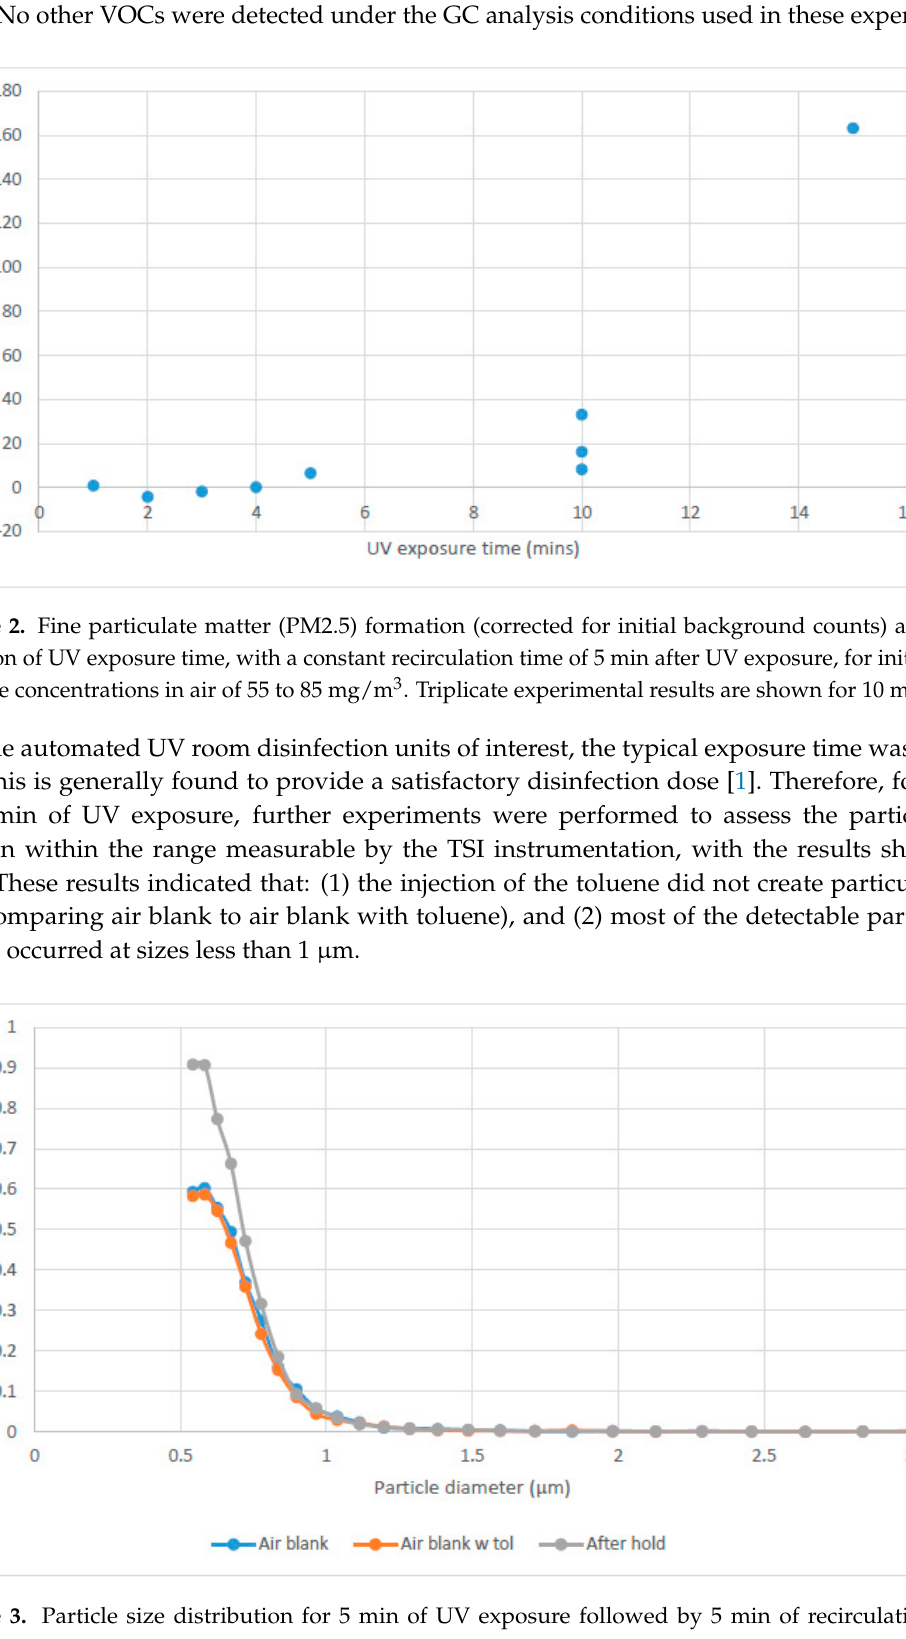
Figure 3. Particle size distribution for 5 min of UV exposure followed by 5 min of recirculation (hold) post-UV.